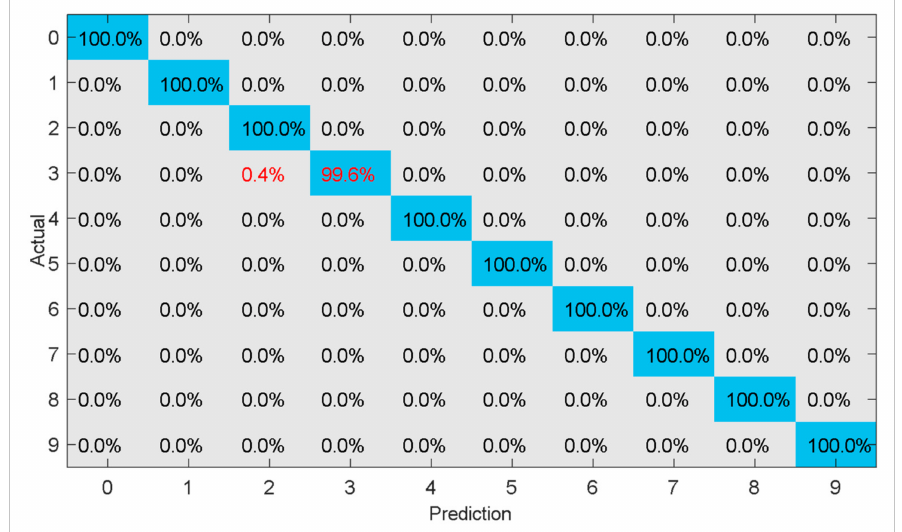
Figure 7. Confusion matrix results with